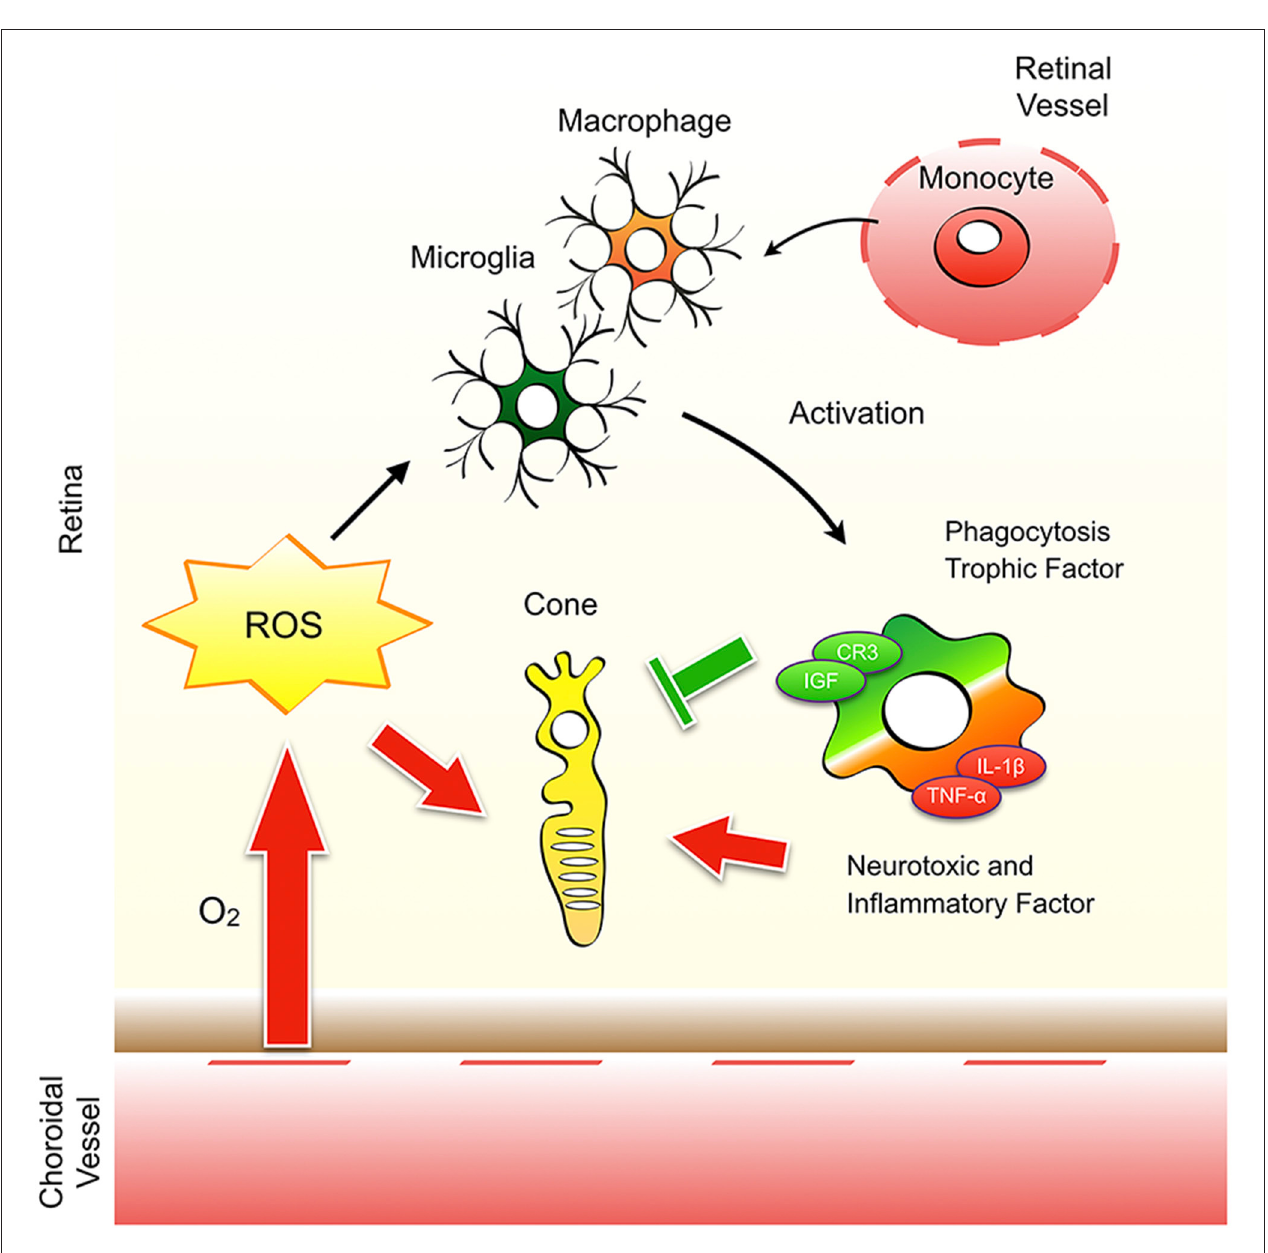
FIGURE 3 | Oxidative stress modulates cone cell survival and neuroinflammation in retinitis pigmentosa. The remaining cones in retinitis pigmentosa (RP) are exposed to a high level of oxygen and the resultant reactive oxygen species (ROS). ROS have a direct harmful effect on cone cells and affects the activation of microglia and monocyte-derived macrophages. Activated microglia/macrophage have a bidirectional function to protect or promote cone cell death. Which environmental factors (e.g., ROS, molecules released from dead cells) and cellular factors (e.g., microglia vs. macrophage) are critical to determine the homeostatic vs. neurotoxic function of microglia/macrophage in RP is